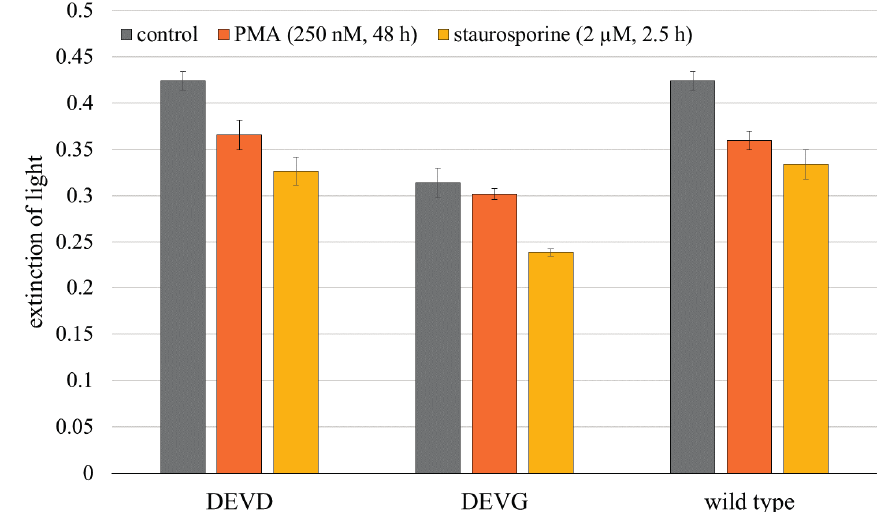
Figure 7. MTT (3-(4,5-dimethylthiazol-2-yl)-2,5-diphenyltetrazolium bromide) assay of HeLa cells without any treatment (control) and subsequent to application of staurosporine (2 µM, 2.5 h) or PMA (250 nM, 48 h). Medians ± median absolute deviations (MADs) of optical density readouts were determined after three independent measurements at 550 nm (background wavelength: 630